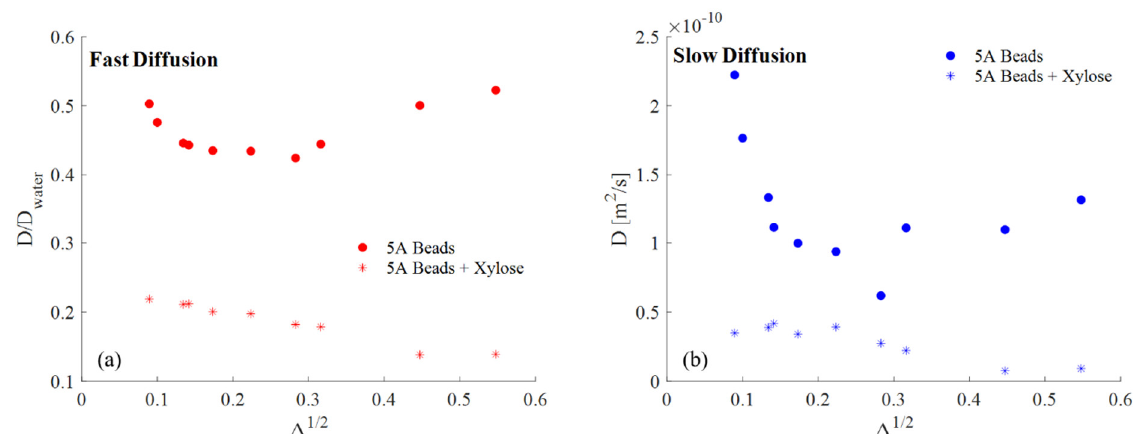
Figure 4. Diffusion coefficients calculated from the biexponential fits to the Stejskal–Tanner plots at each Δ, plotted against Δ 1/2 for the zeolite beads with the pure water and xylose solution for the fast ( a ) and slow ( b ) diffusion component. The fast diffusion is plotted normalized by the free water diffusion coefficient 2.0 × 10 − 9 m 2 /s. The presence of the xylose significantly decreases both the fast and slow diffusion coefficients in the beads. The increase in diffusion of pure water in the zeolite at longer Δ indicates some nonstationary water redistribution.